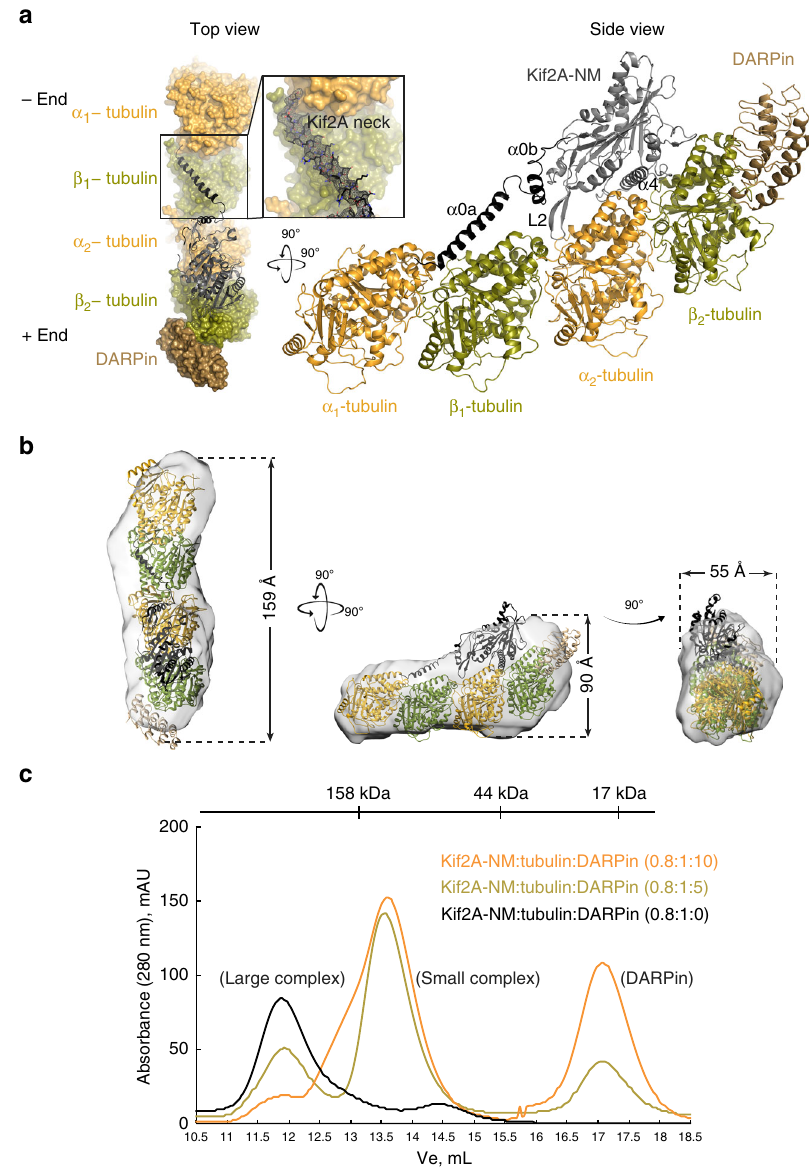
Fig. 2 Structure of Kif2A-NM in complex with tubulin and DARPin. a The X-ray crystal structure of a Kif2A-NM – tubulin – DARPin complex is shown in two views (from the top and side of the tubulin fi lament). The Kif2A is in black; α -tubulin is in orange; β -tubulin is in green; and DARPin is in light brown. The insert represents the F obs − F calc omit map (contoured at 3.0 σ ) of the neck of Kif2A-NM calculated after deletion of the neck from fi nal model. All fi gures of structural models were generated with PyMOL 67 . b SAXS envelopes for the Kif2A-NM – tubulin – DARPin complex. The crystal structure of the complex shown in ribbons representation and superimposed onto envelopes (in gray) by Chimera 68 . c SEC pro fi les of mixtures of Kif2A-NM, tubulin, and DARPin at the indicated molar ratios. All mixtures were supplemented with 0.1 mM AMPPNP and passed through a Superdex 200 10/300 GL column in HEPES